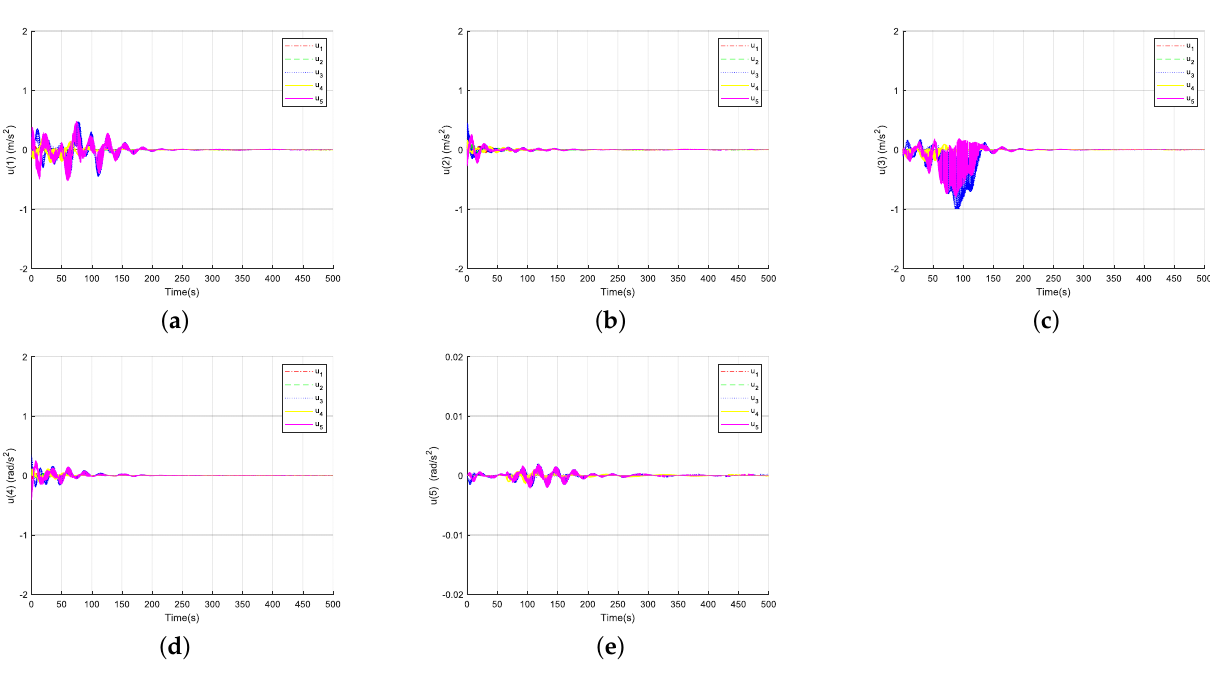
Figure 6. The control input u of the multi − AUV formation: ( a ) the u ( 1 ) state of multi − AUV, ( b ) the u ( 2 ) state of multi − AUV, ( c ) the u ( 3 ) state of multi − AUV, ( d ) the u ( 4 ) state of multi − AUV, ( e ) the u ( 5 ) state of multi −